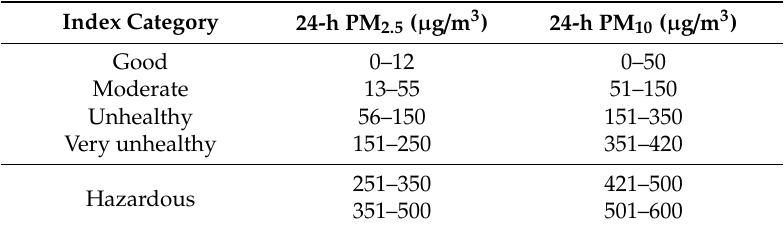
Table 4. Breakdown used to define the index for PM 2.5 and PM 10